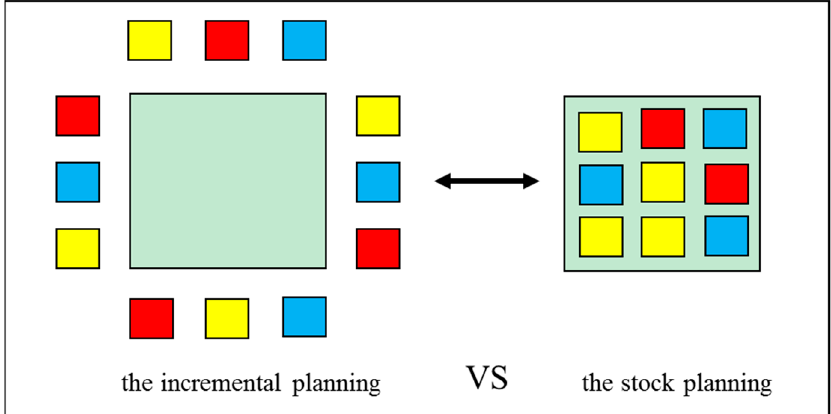
Figure 3. Difference between incremental planning and stock planning.